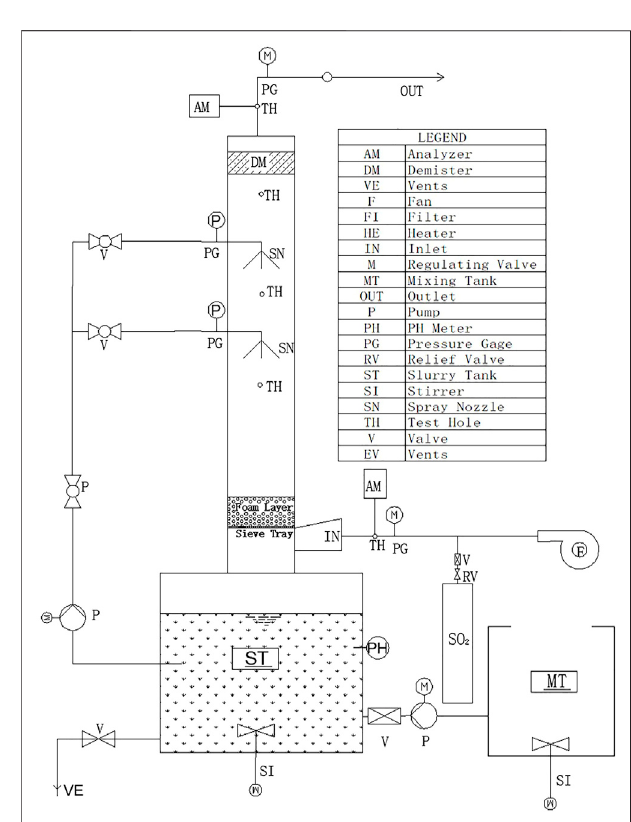
FIGURE 2 | Diagram showing the experimental setup of the WFGD